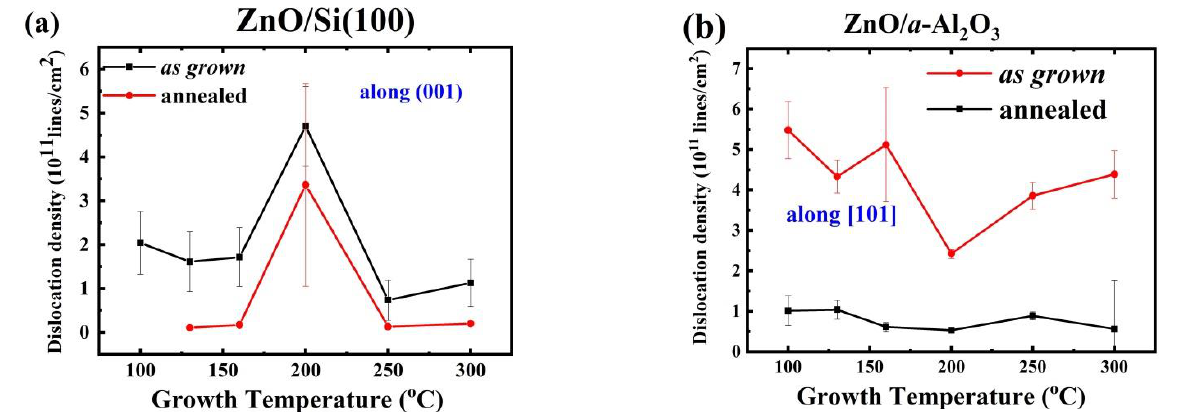
Figure 6. Dislocation density versus T g for as grown and annealed films ( a ) along the preferentially oriented [001] crystallites in ZnO/Si films and ( b ) along the [101]-oriented crystallites in ZnO/ a -Al 2 O 3 films.